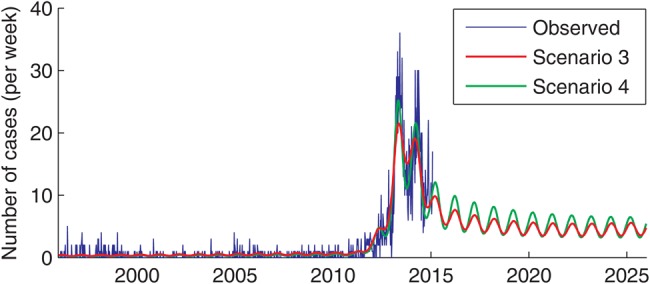
Model projection of weekly number of culture-confirmed Salmonella Typhi infections at Queen Elizabeth Central Hospital in Blantyre, Malawi, 1996–2025.